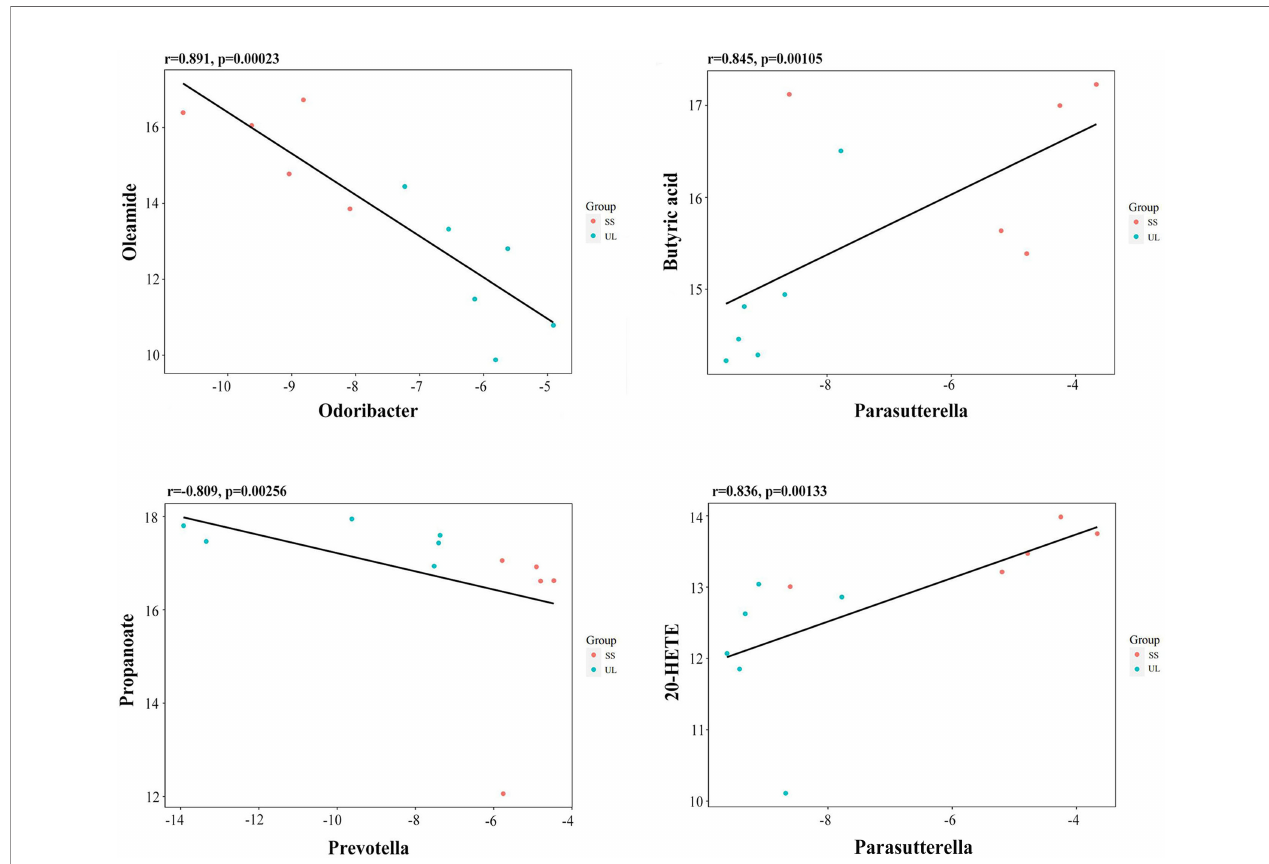
FIGURE 6 | Scatter plots illustrating the statistical correlation between the relative abundance of altered gut bacterial genera and LC-MS spectrum intensities of the differential